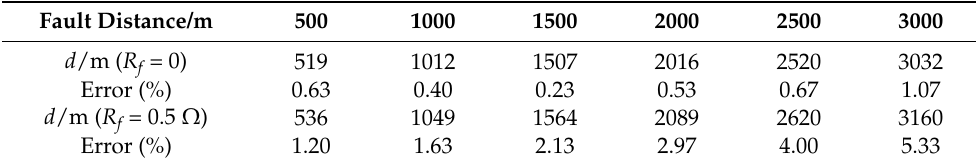
Table 4. Results for the improved proposed location method.